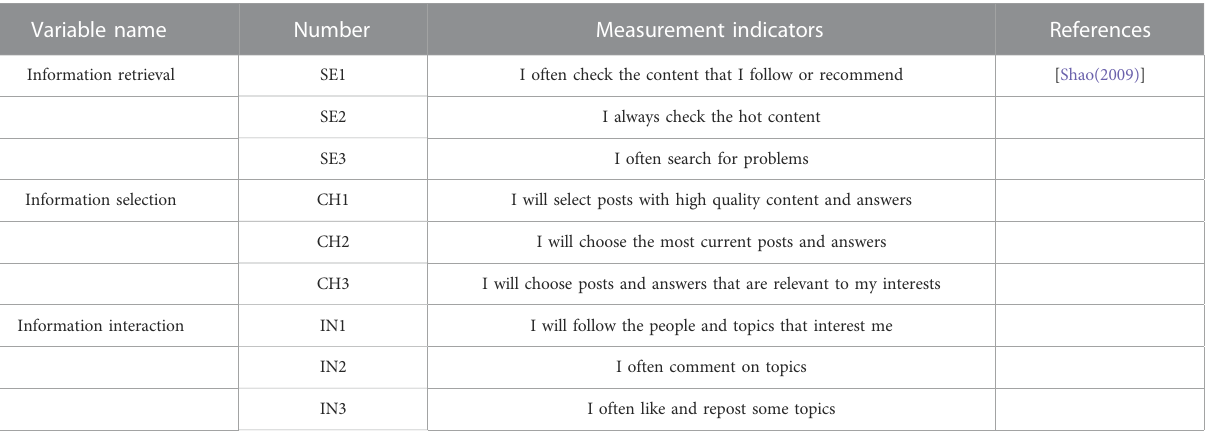
TABLE 3 Information behavior measurement